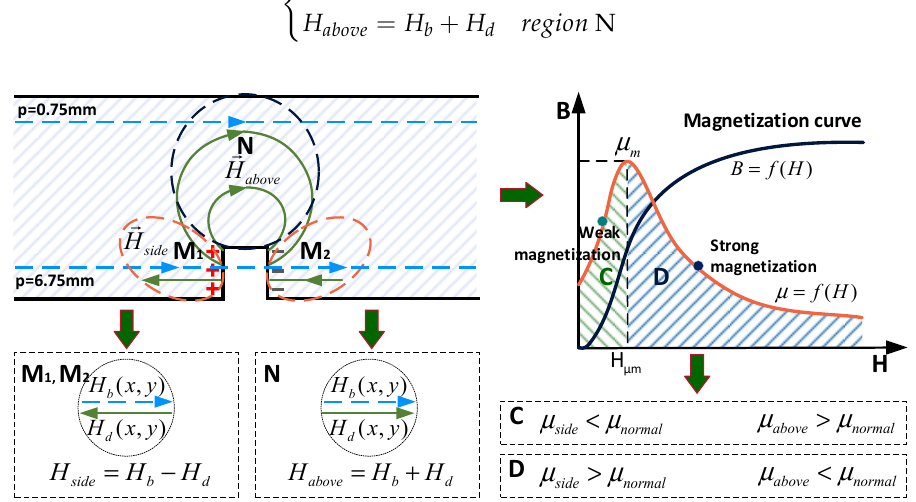
Figure 5. Mechanism of permeability perturbation hidden in the present magnetizing-based eddy current testing.